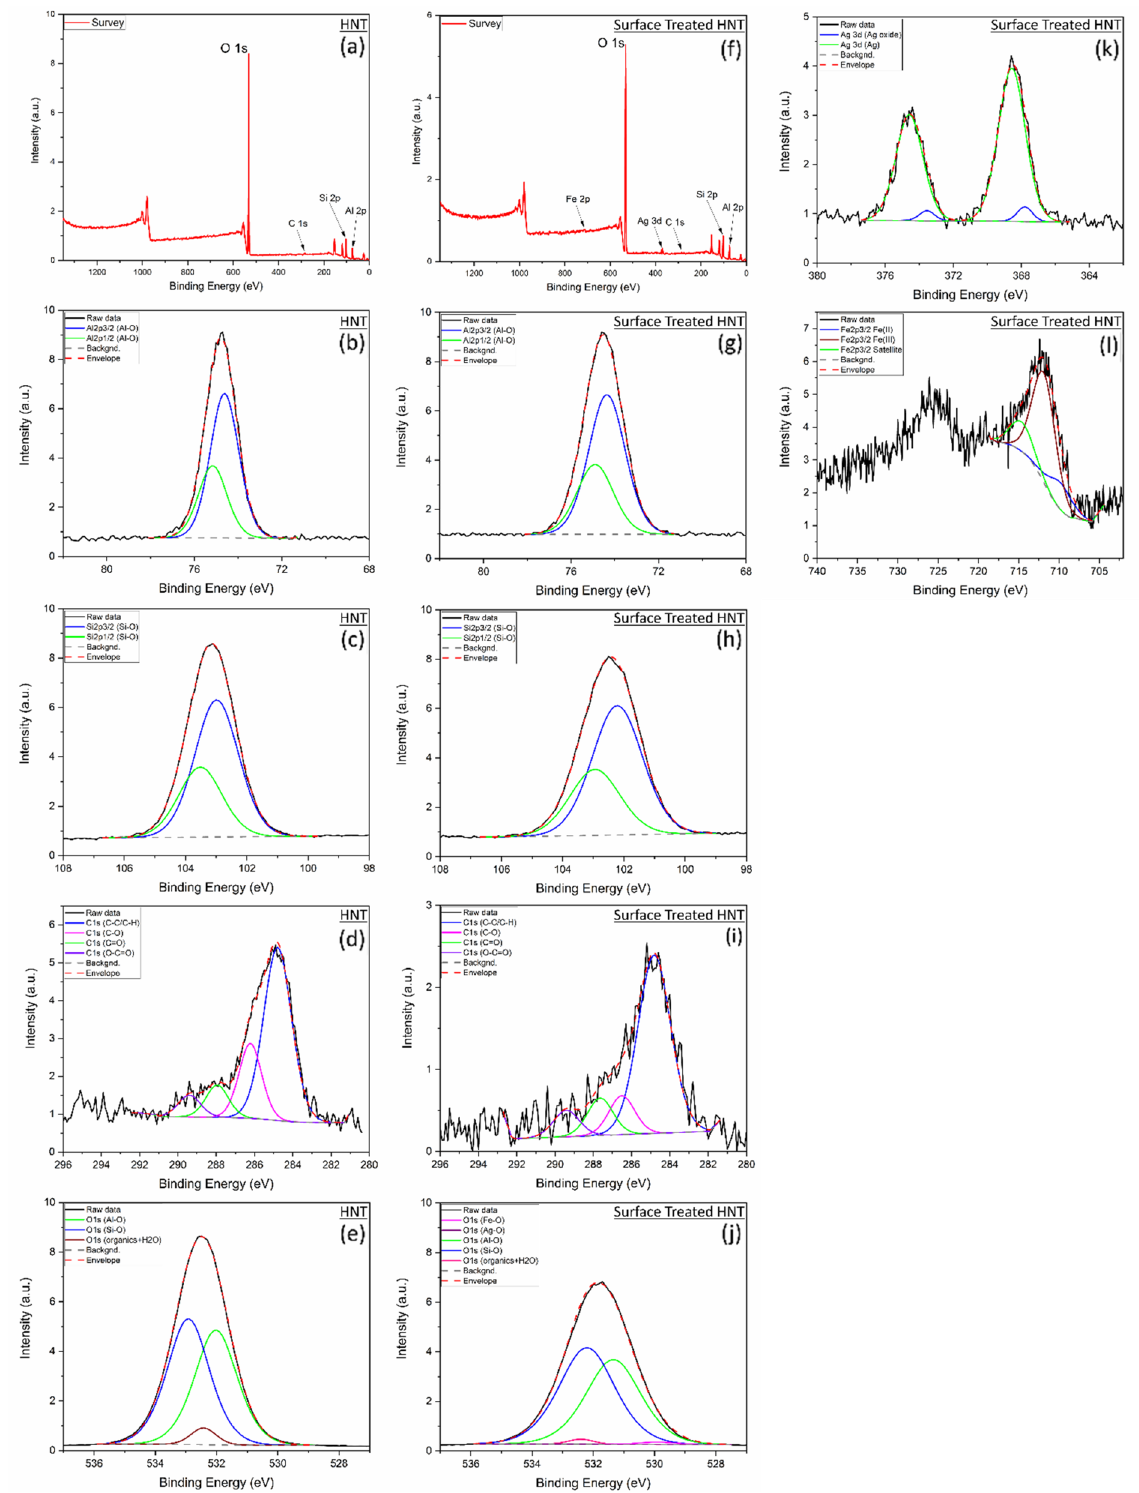
Figure 8. HNT XPS spectra including data fitting for ( a ) Survey, ( b ) Al 2p, ( c ) Si 2p, ( d ) C 1 s, ( e ) O 1 s. Surface treated HNT spectra including data fitting for ( f ) Survey, ( g ) Al 2p, ( h ) Si 2p, ( i ) C 1 s, ( j ) O 1 s, ( k ) Ag 3d, ( l ) Fe